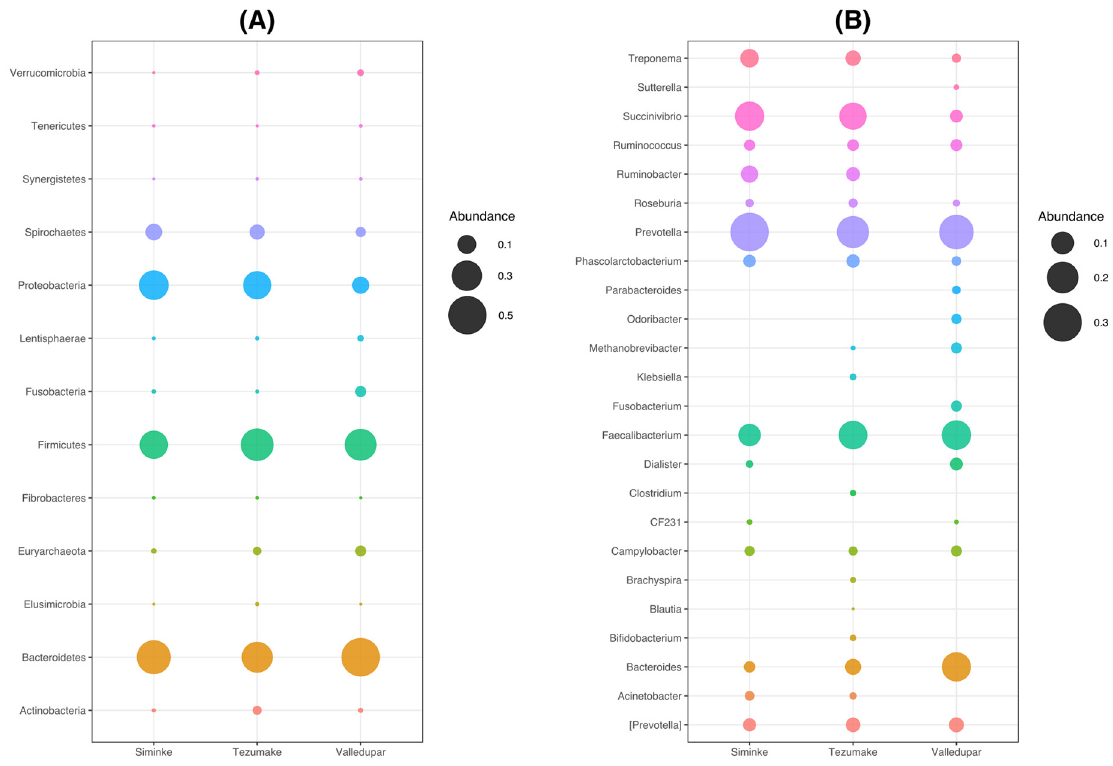
Figure 1. Community composition by location. ( A ) Phylum distribution, unfiltered. ( B ) Genera distribution (Genera > 2%).